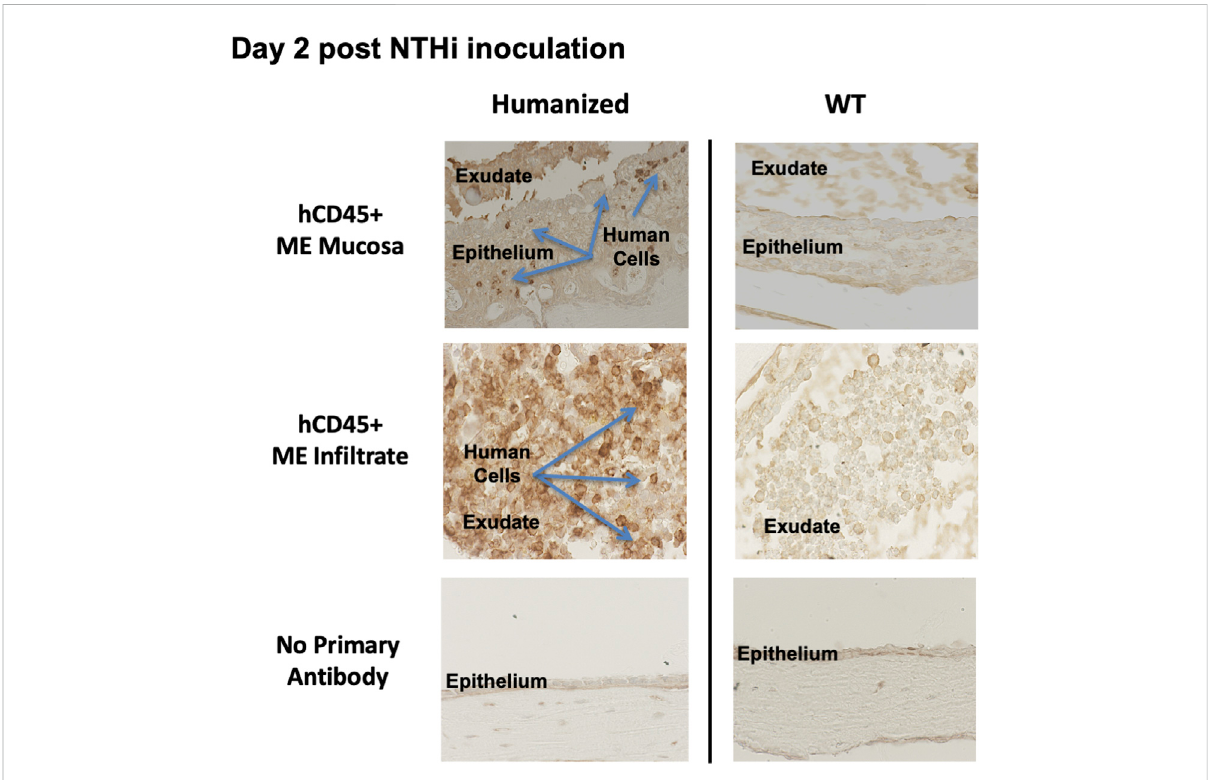
FIGURE 5 Human CD45 + cells behave like mouse CD45 + cells in the in fi ltration of ME space and support appropriate in fl ammatory response. Immunohistological staining by human leucocyte Common Antigen (hCD45 + , DAKO) of ME sections at day 2 post NTHi infection showing that human CD45 + immune cells were detected in mucosa and ME effusions of mice with humanized immune systems but not WT. In fi ltration of hCD45 positive cells into the MEmucosa and lumen strongly suggests that thehuman immune cells are playing arole in both ME in fl ammation and NTHi bacterial